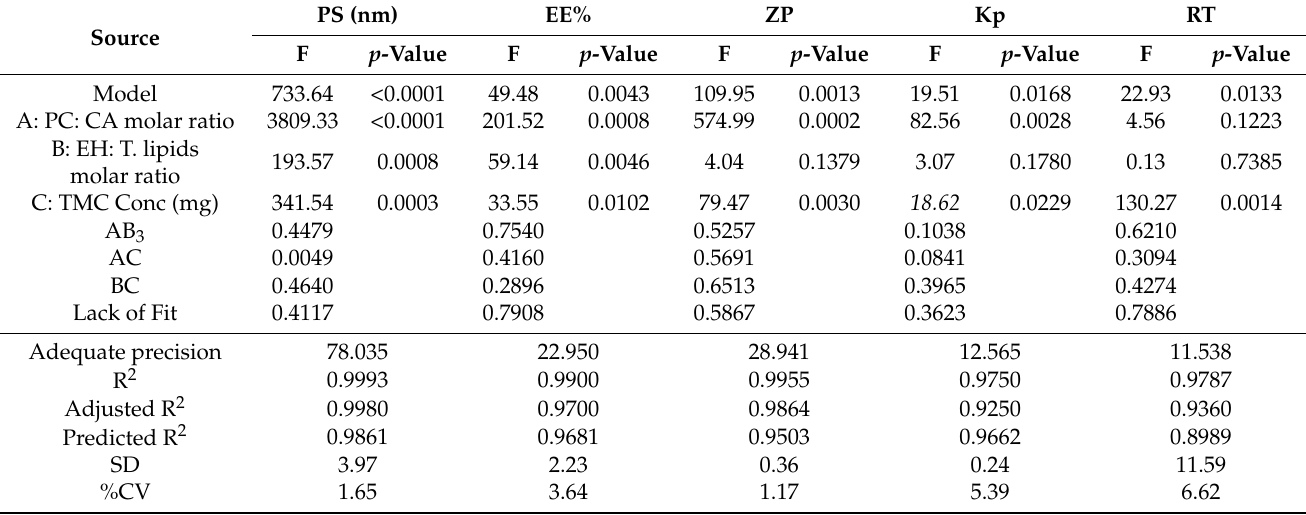
Table 3. The design expert results of all response variables.